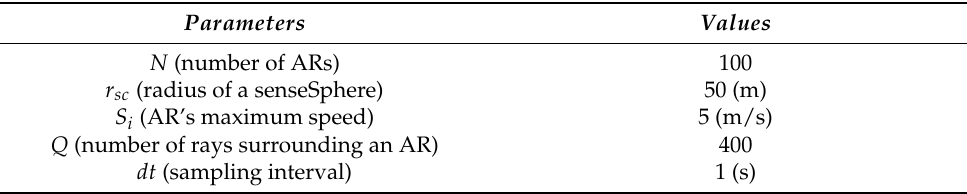
Table 1 summarized the parameters in our paper. Table 1. The simulation